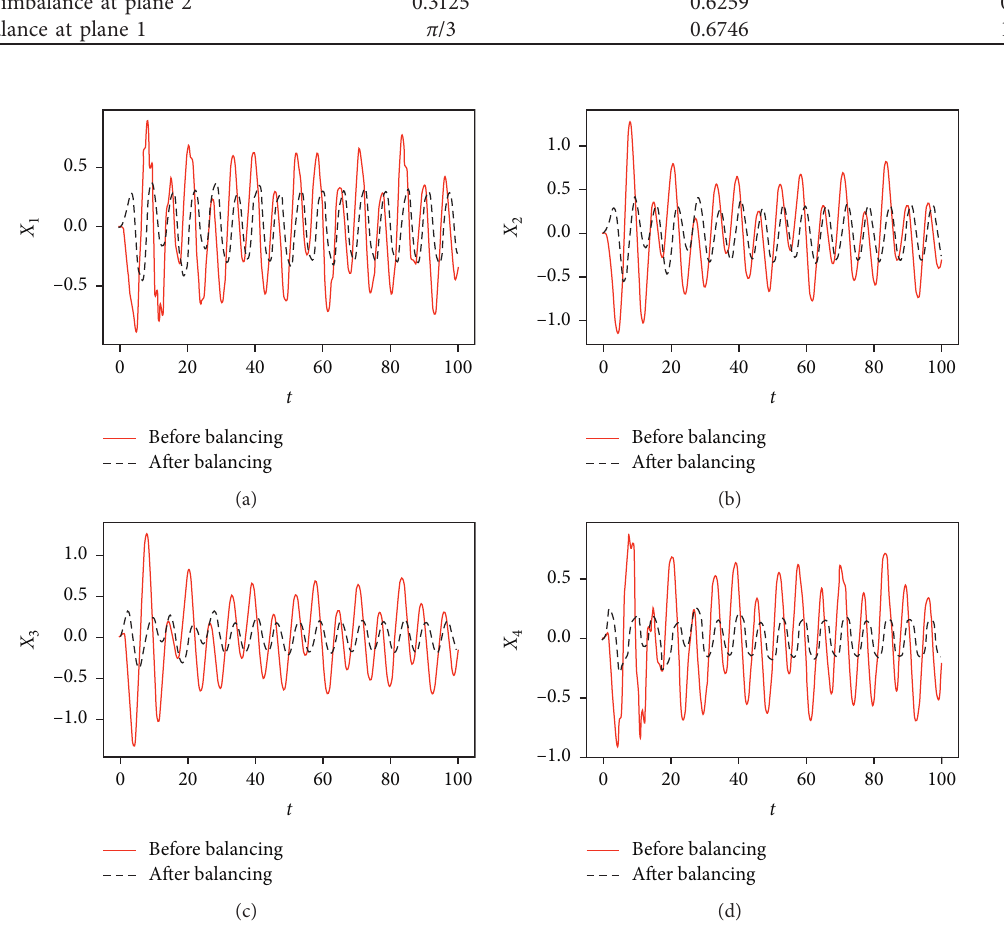
Figure 6: Balancing effects on the (a) left end; (b) left disk; (c) right disk; and (d) right